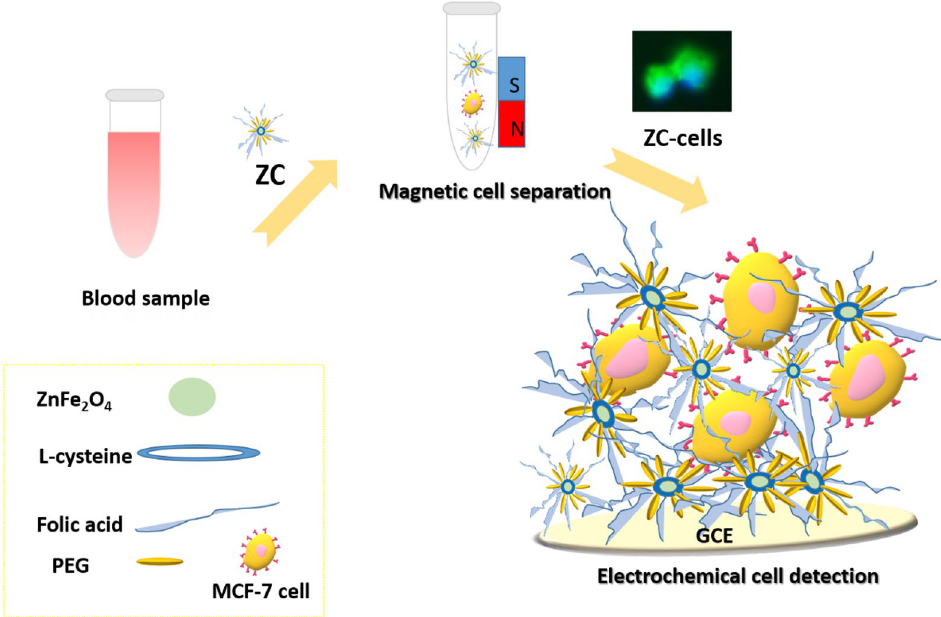
Figure 1. The scheme shows the magnetic separation and the electrochemical detection of MCF-7 using